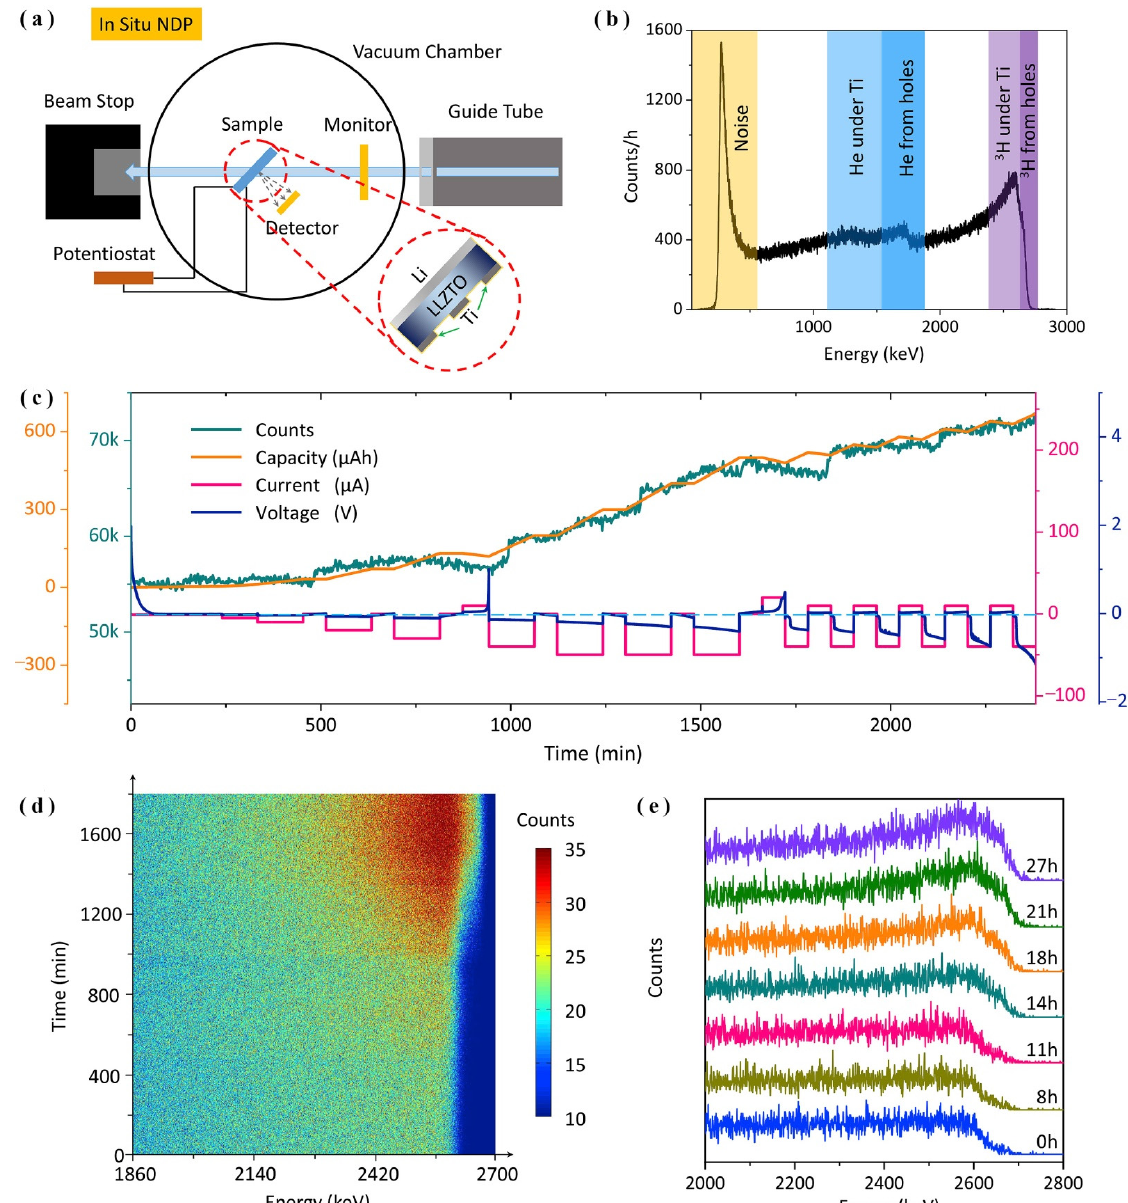
Figure 11. ( a ) The experimental set-up of the NDP system, ( b ) ASSLB NDP spectrum with a 3D Ti electrode, ( c ) records of in situ measurements in terms of voltages, capacity, and the total number of NDP signal, ( d ) NDP spectra collected at 3 min intervals during cycling and ( e ) NDP data integrated curves collected every 1 h during Li plating-stripping of Li/LLZO/Ti SSLBs (adapted with permission from Ref. [39]. 2019 Elsevier).